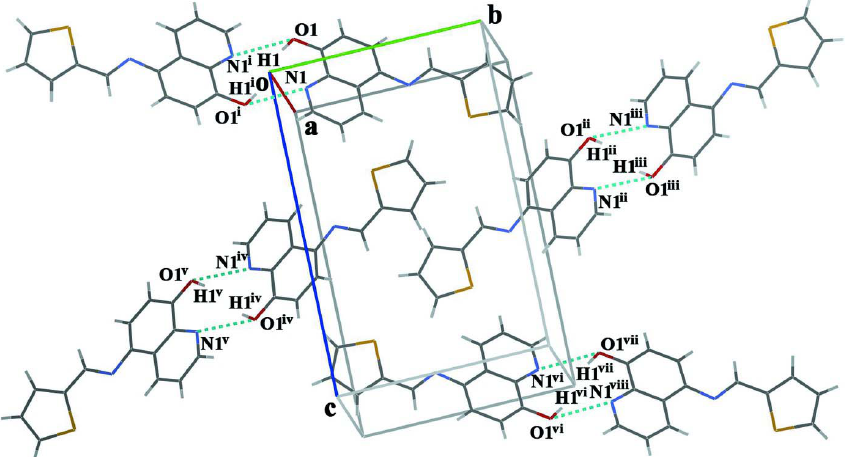
The lattice structure of (I) showing hydrogen bonding. [Symmetry codes: (i) - x , - y , - z ; (ii) ( E )-5-(2-Thienylmethyleneamino)quinolin-8-ol Crystal data H N C 14 10 2